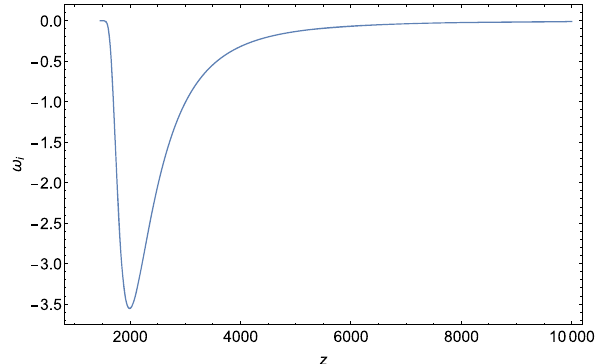
Fig. 3 Damping coefficient ω i (in 10 − 16 Hz) vs redshift z